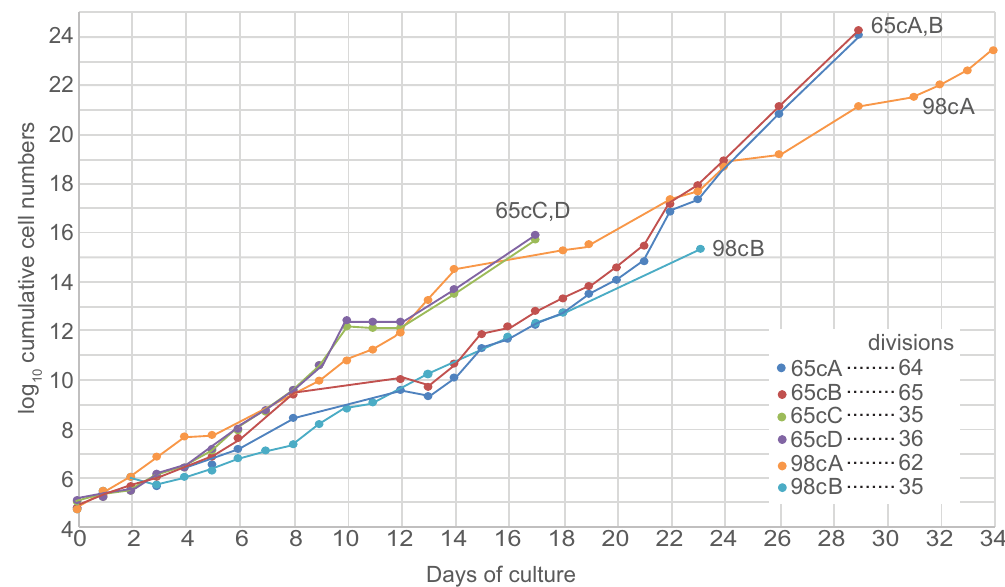
Fig 3. Growth in culture. Cumulative cell counts for all cultures that were used for DNA preparation. Full details of these cultures with linear-scale plots are in S2 Fig panels C-I.